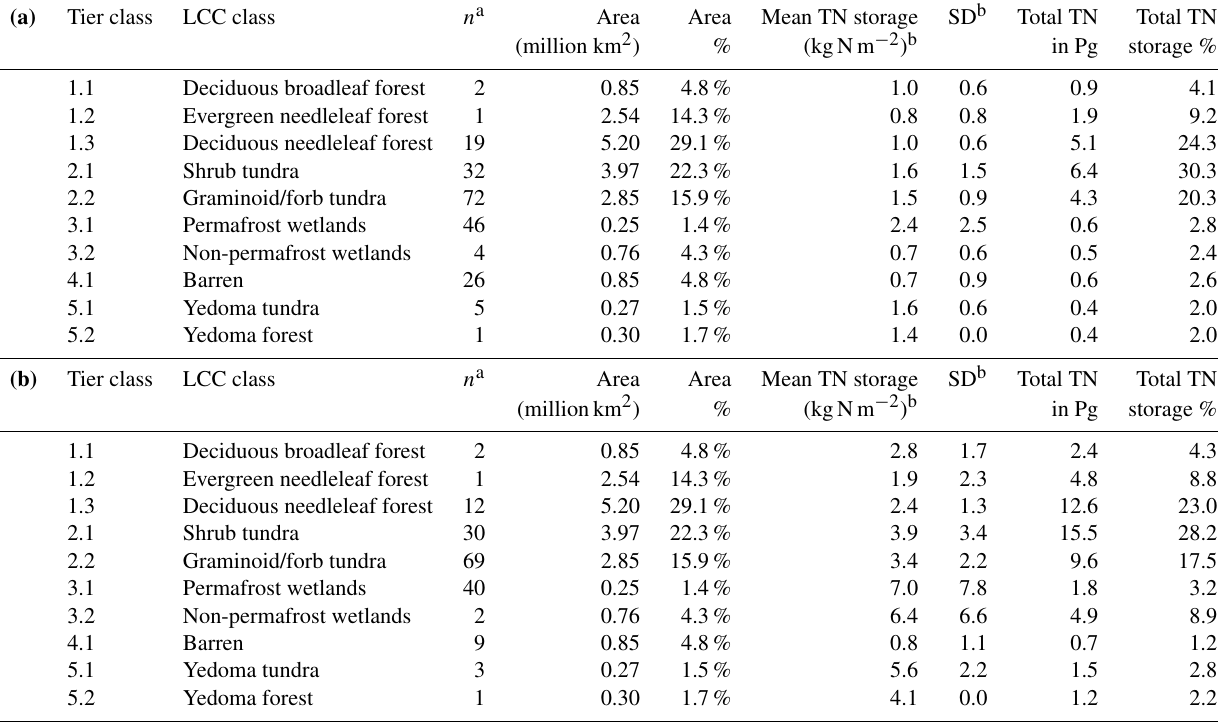
Table 7. Mean and total TN storage for (a) 0–100cm and (b) 0–300cm soil depth separated for the different Tier classes within the northern circumpolar permafrost region, excluding water bodies and permanent snow and